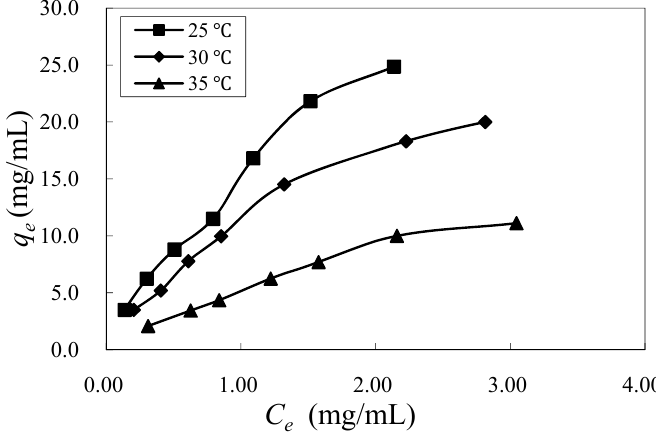
Figure 3. Adsorption isotherms of mogroside V on HZ 806 at different